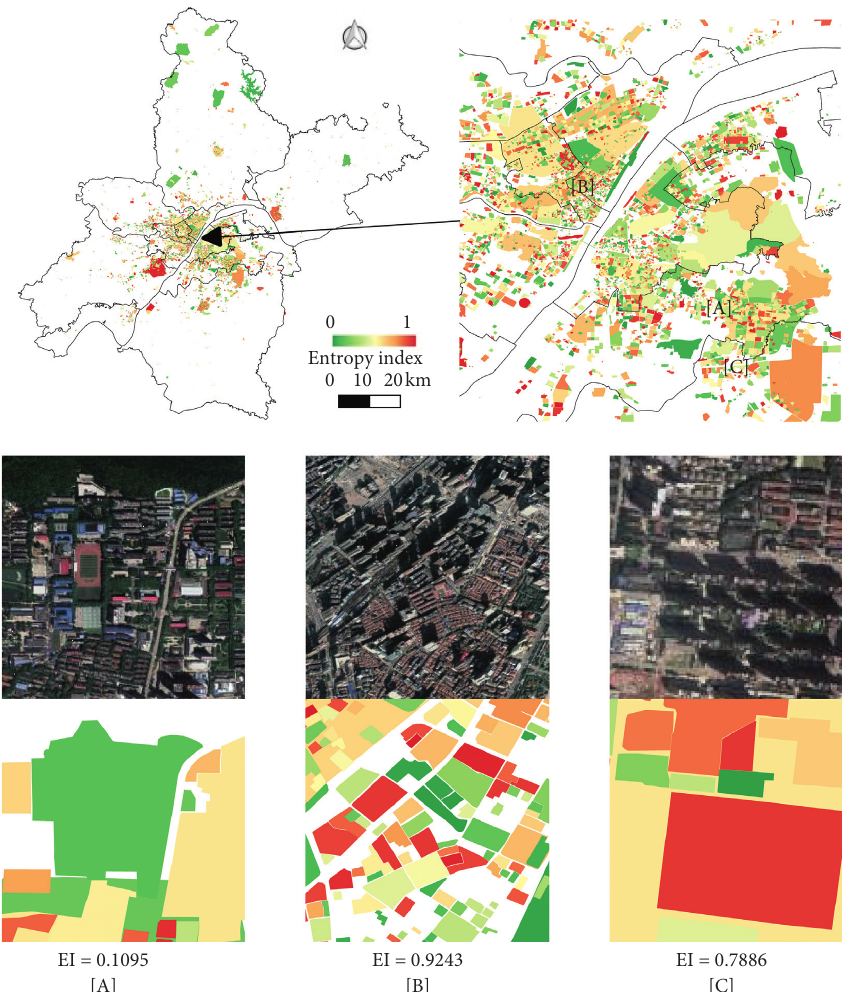
Figure 10: Mixed jobs-housing results for Wuhan: (A) China University of Geosciences, (B) Hankou River Beach, and (C) Guanggu Software